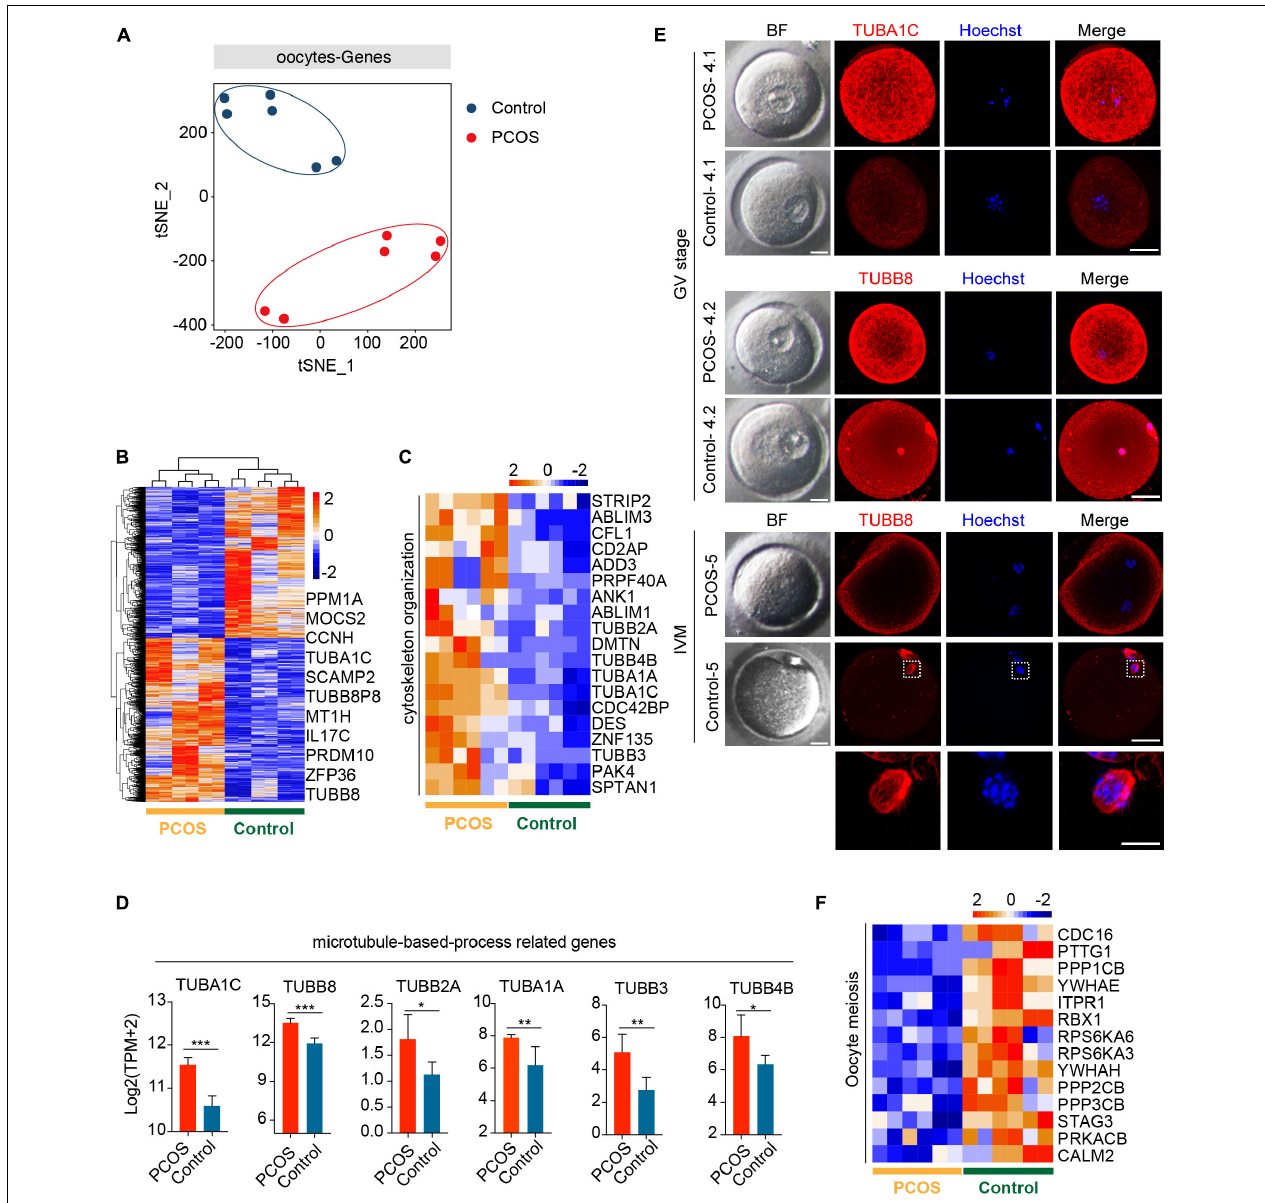
FIGURE 1 | Global gene expression profile distinguishes polycystic ovary syndrome (PCOS) from control oocytes. (A) Visualization of the gene expression of six oocytes by t-SNE, which are clustered into two subpopulations including the control group and the PCOS group; the red and blue points represent PCOS and control oocytes, respectively. (B) Heat map displaying differentially expressed genes (DEGs) in oocytes between PCOS and control. The number of up-DEGs is 1,433 and down-DEGs is 1,322. The color key from blue to red indicates the relative gene expression levels from low to high, respectively. (C) Heat map of genes involved in cytoskeleton organization that were upregulated in PCOS oocytes. (D) Six genes associated with a microtubule-based process. The red and blue bars represent PCOS and control, respectively. The gene expression levels are represented by log 2 [TPM + 2], and data represents mean ± SD. n = 3 (participants). * p < 0.05, ** p < 0.01, *** p < 0.001, ns, not significant. (E) Bright-field and immunofluorescence images of TUBA1C and TUBB8 in normal and PCOS oocytes at the germinal vesicle (GV) stage or metaphase II (MII) stage after in vitro maturation. Upper panel, oocytes (PCOS and control) at GV stage and two PCOS oocytes or two control oocytes were obtained from the same person. Lower panel, oocytes (PCOS and control) after in vitro maturation. Hoechst (blue) was used to counterstain and visualize DNA. Scale bar represents 20 µ m. The magnifications of the spindle regions are shown at the bottom, and the scale bar is 10 µ m (bottom). (F) Heat map of genes associated with oocyte meiosis downregulated in PCOS